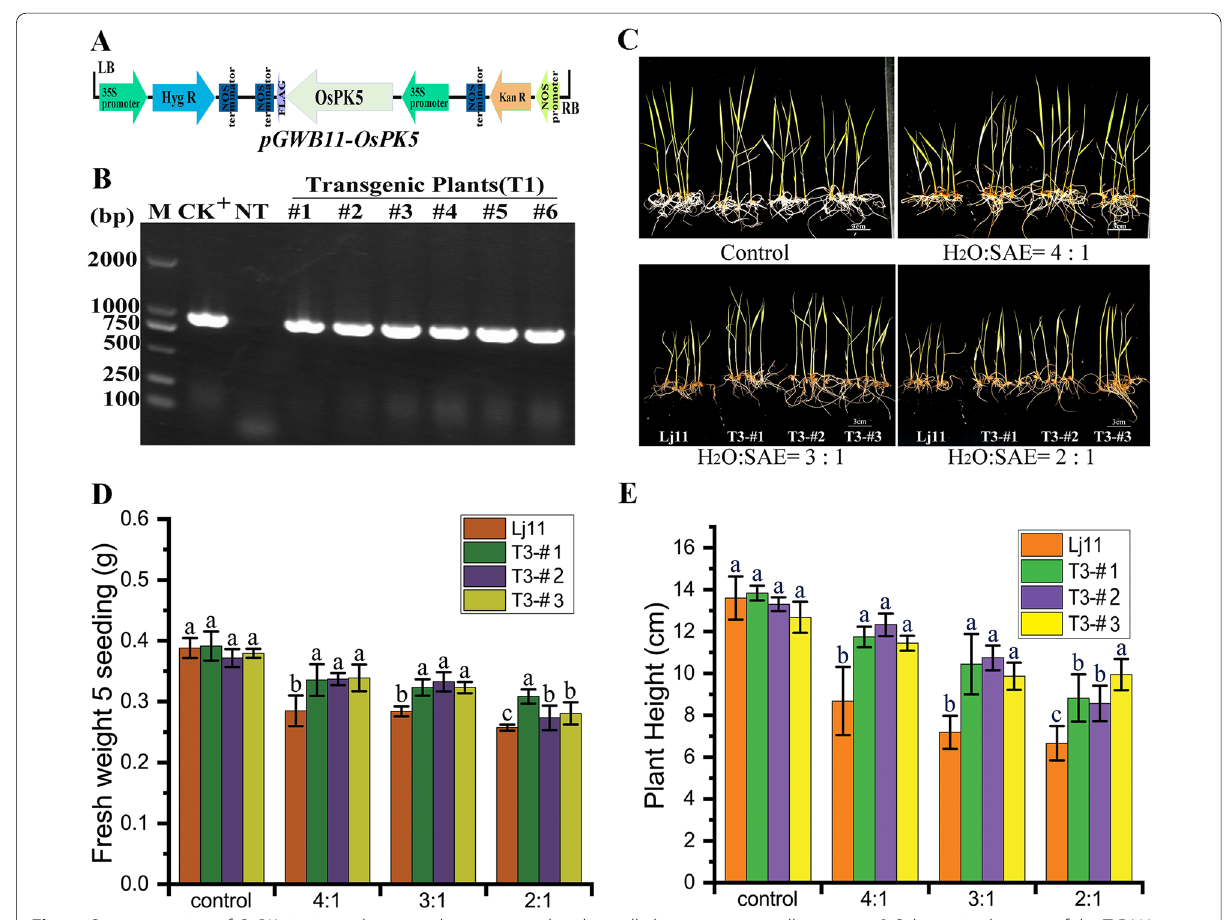
Fig. 7 Overexpression of OsPK5 in rice enhances tolerance to soda saline–alkaline stress at seedling stage. A Schematic diagram of the T-DNA insertion site in OsPK5 overexpression lines. B RT–PCR detection of OsPK5 transcripts in 6 independent transgenic lines of rice; M, Marker, DL2000; CK , positive control, pGWB11- OsPK5 ; NT, Nontransgenic lines, Lj11. C Phenotypes of Lj11 and OsPK5 overexpression lines T3-#1, 2 and 3 under + SAE stress